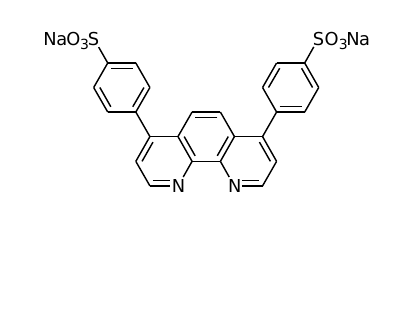
Figure 1. Chemical structure of